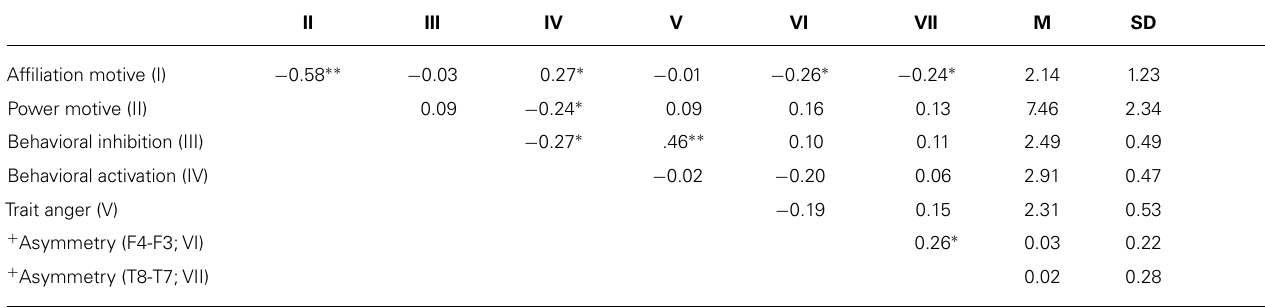
Table 1 | Means, SD, and correlations for affiliation and power motives, BIS, BAS, and trait anger with resting EEG alpha power asymmetry scores.